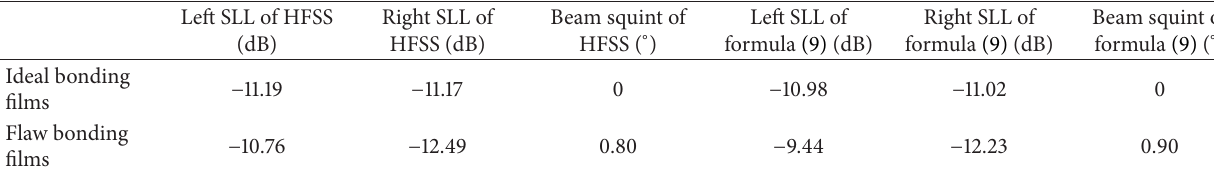
Table 6: Comparison of far field parameters between HFSS and this formula.